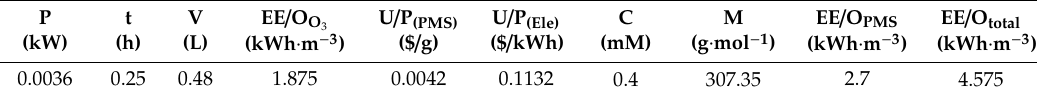
Table 2. Cost of O 3 / PMS for ACE